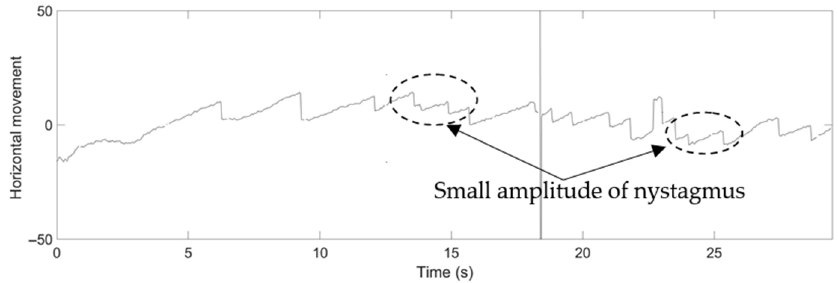
Figure 15. Nystagmus waveform from the proposed method for Video No. 28, horizontal movement of the pupil.